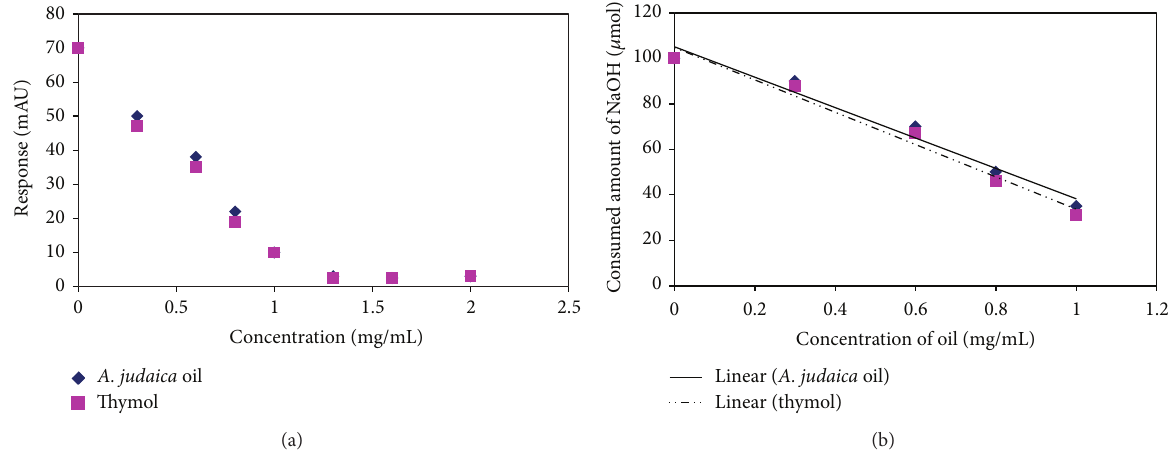
Figure 2: (a) Linearity study for the effect of A. judaica oil and thymol on the response of IR carbonyl stretching of CO 2 ; samples of concentrations within the range of 0-1.0 mg/mL showed a linear behavior ( 𝑅 > 0.99 ). (b) Linearity study of CO 2 solution treated with several concentrations of A. judaica oil and thymol versus the consumed amount of NaOH needed to neutralize them ( 𝑅 > 0.98 ). The close similarity between slopes of curves (a) and (b) implies the accuracy of IR method in quantifying CO 2